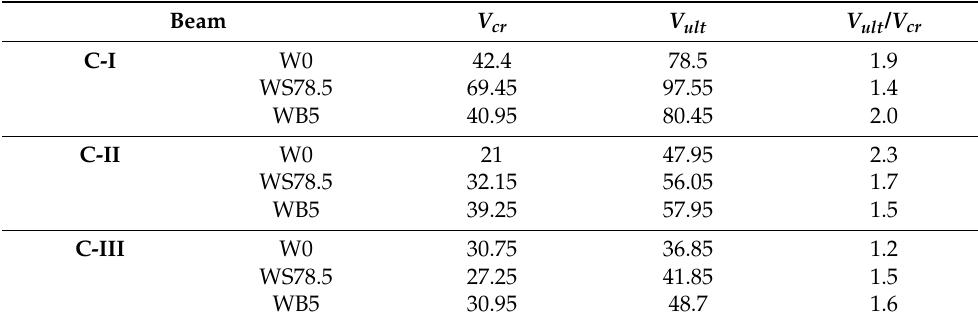
Table 3. Summary of Average Values of Shear Forces Causing Diagonal Cracking V cr and Shear Forces V ult at Maximum Load (at the central